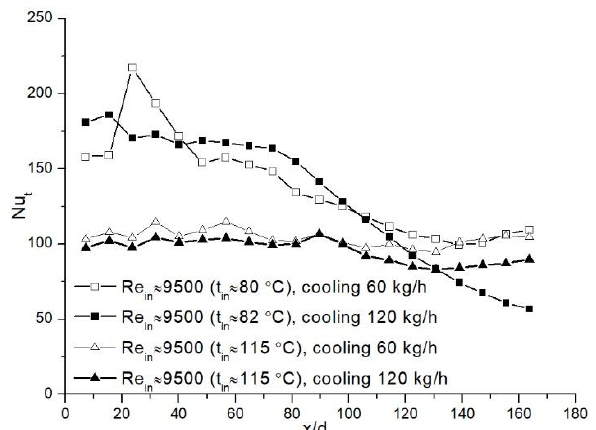
Figure 4. Comparison of the Nu t distribution along the heat exchanger at Re in ≈ 9500, at different inlet temperatures, as well as cooling water flow rates.